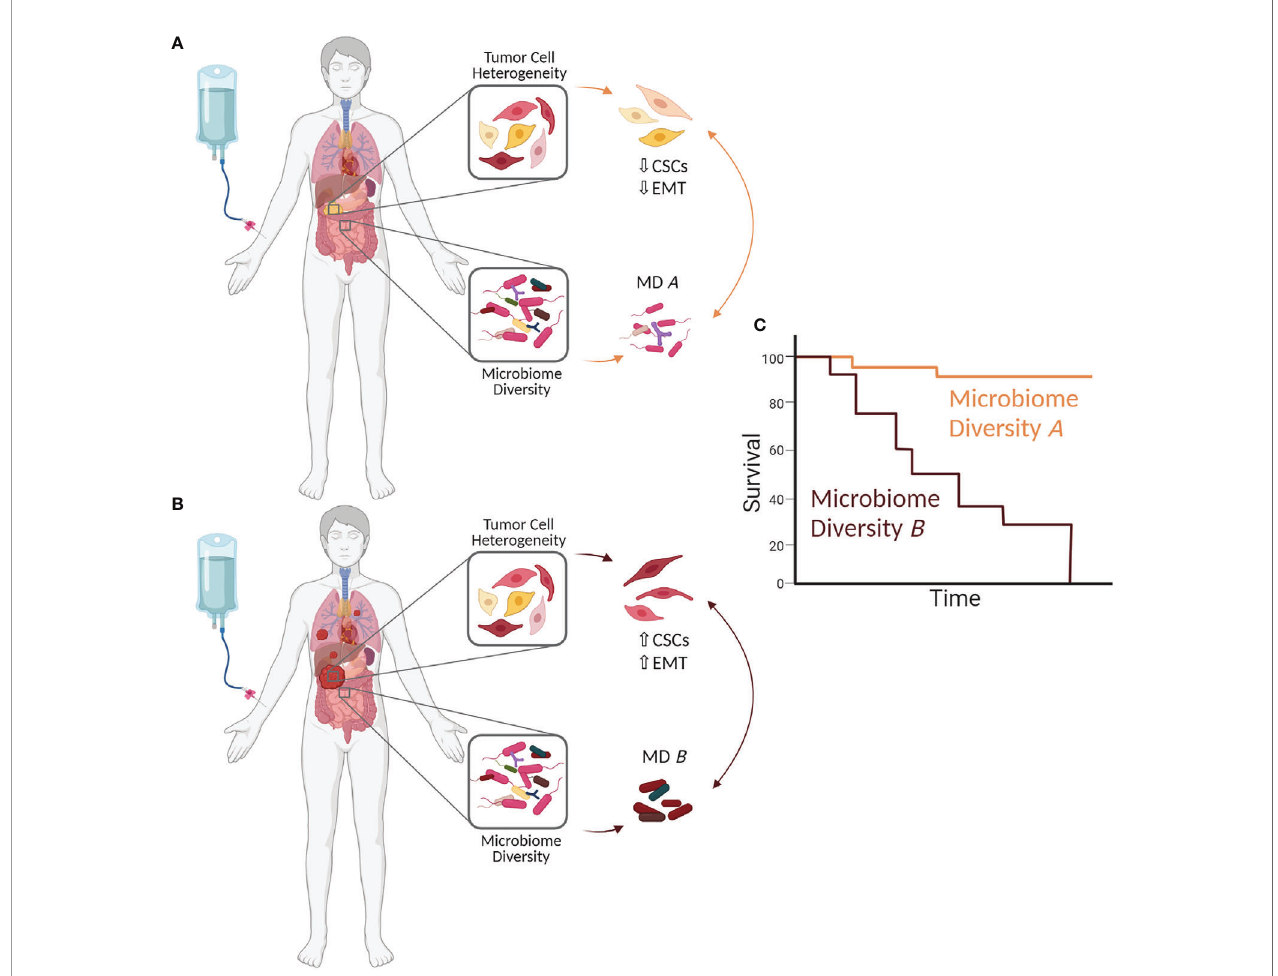
FIGURE 1 | The microbiome impacts clonal heterogeneity of PDAC cells and thereby a patient´s outcome. Changes in the microbiome composition (in the tumor but also other body compartments) may in fl uence Epithelial-Mesenchymal-Transition (EMT) and the abundance and phenotype of cancer stem cells (CSCs) in the tumor by generating optimal niche conditions and impacting their survival and expansion. This in turn impacts PDAC growth and progression as well as therapy responses and outcome of PDAC patients. (A) Microbiome diversity A (MD A) may prevent/control EMT induction and the enrichment of CSCs (CSC ↓ ), thereby inhibiting PDAC progression, drug resistance and (C) improving patient´s prognosis. (B) In contrast, microbiome diversity B (MD B) may induce EMT and increase the CSC potential within a tumor (CSC ↑ ). As a consequence, a high CSC abundance promotes PDAC progression and drug resistance leading to (C) poor patient´s outcome. The fi gure was created with